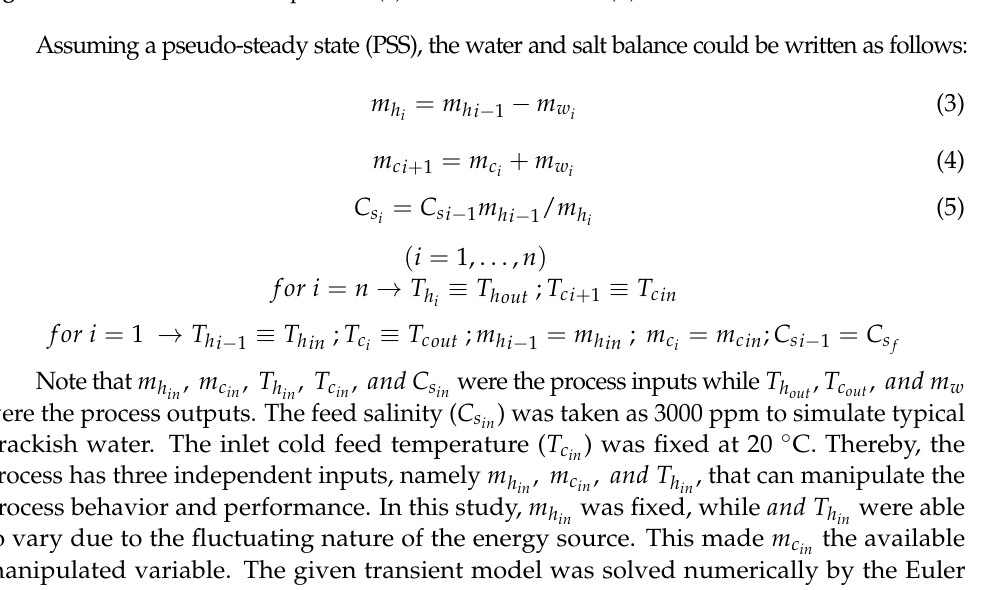
Figure 1. Schematic of the MD process: ( a ) control volume and ( b ) whole module.